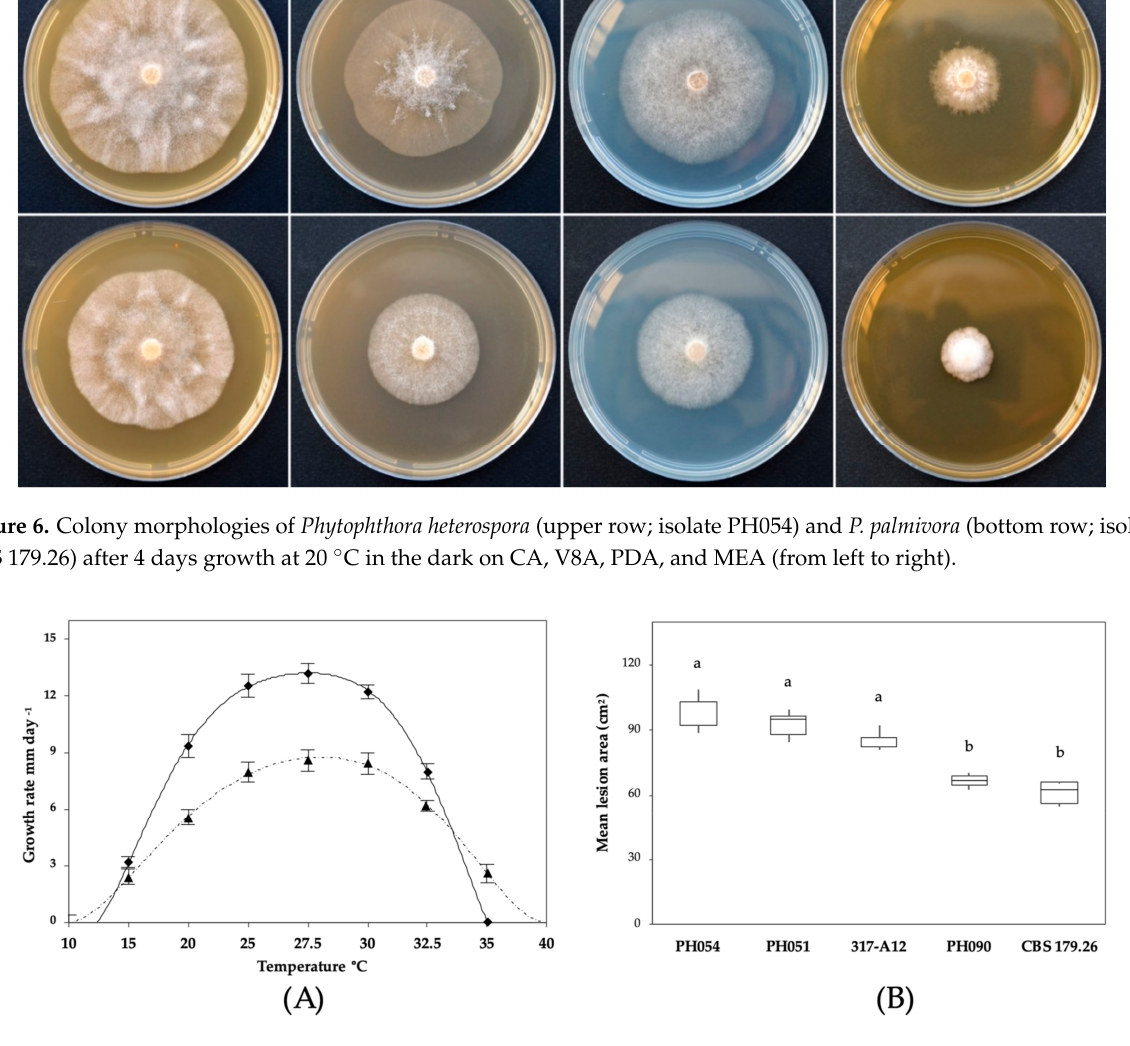
Figure 7. Temperature–growth relations and pathogenicity of Phytophthora taxa: ( A ) radial growth rates of P. heterospora (continuous line; 10 isolates) and P. palmivora (dashed line; 4 isolates) on CA at different temperatures. The data are plotted as average ± SD; ( B ) box and whiskers diagram showing mean lesion areas produced by three isolates of P. heterospora (PH054, PH051, and 317-A12), P. taxon palmivora -like (PH090), and P. palmivora (CBS 179.26) on 2-year-old olive saplings after 2 months. Control saplings did not show any necrotic lesions around the inoculation points and were not included. Different letters above bars indicate significant differences according to Fisher’s LSD test ( p =